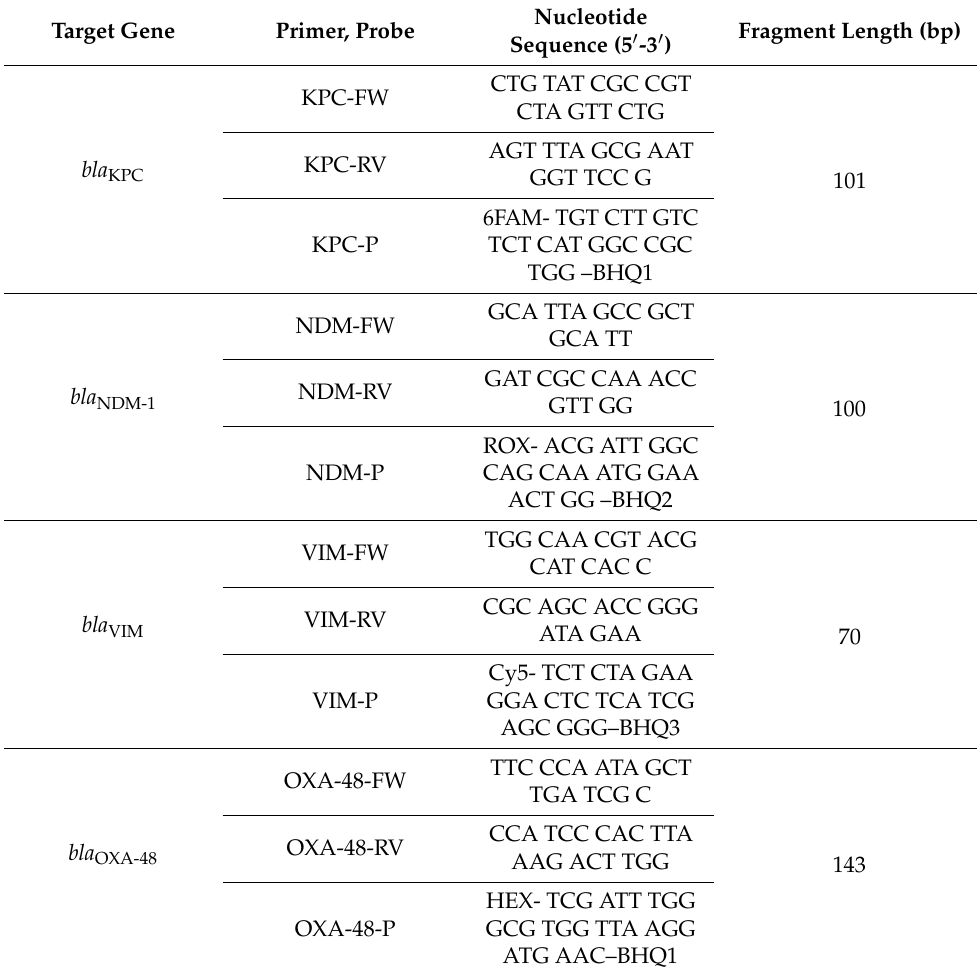
Table 2. Target genes, primers and